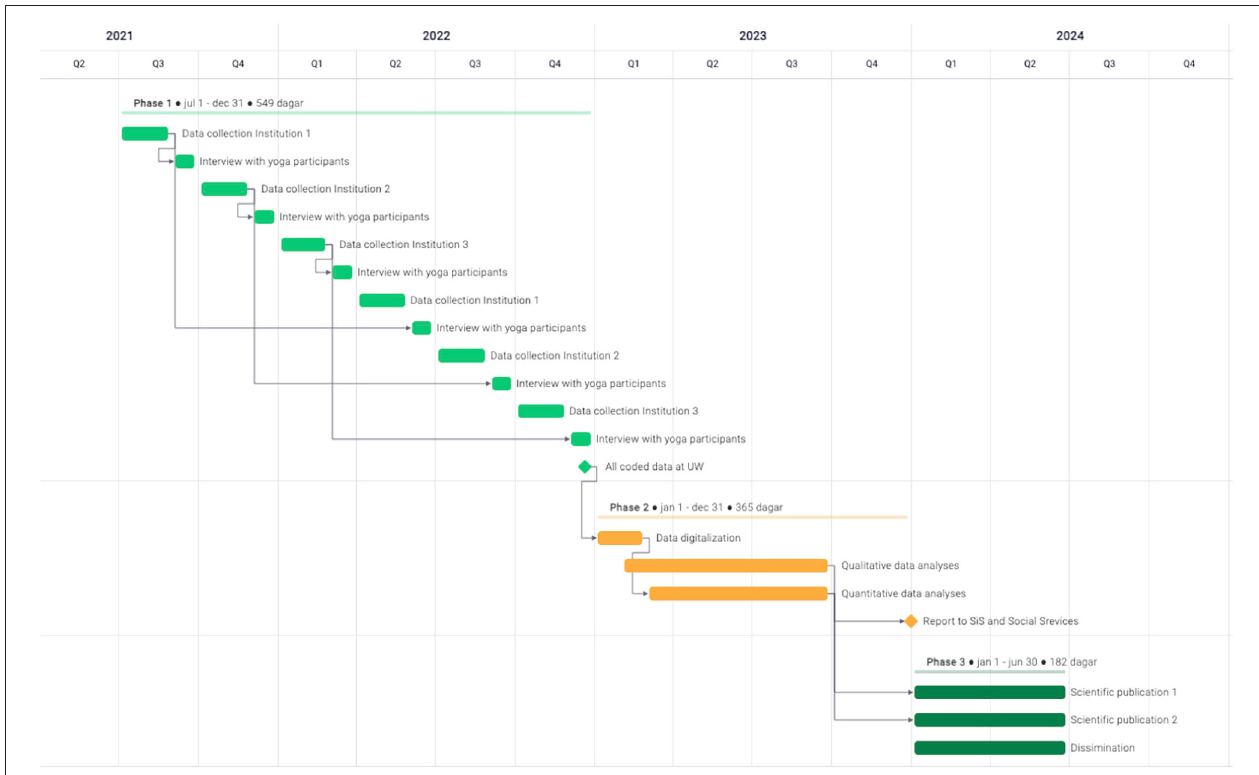
FIGURE 1 | GANTT presentation of the project